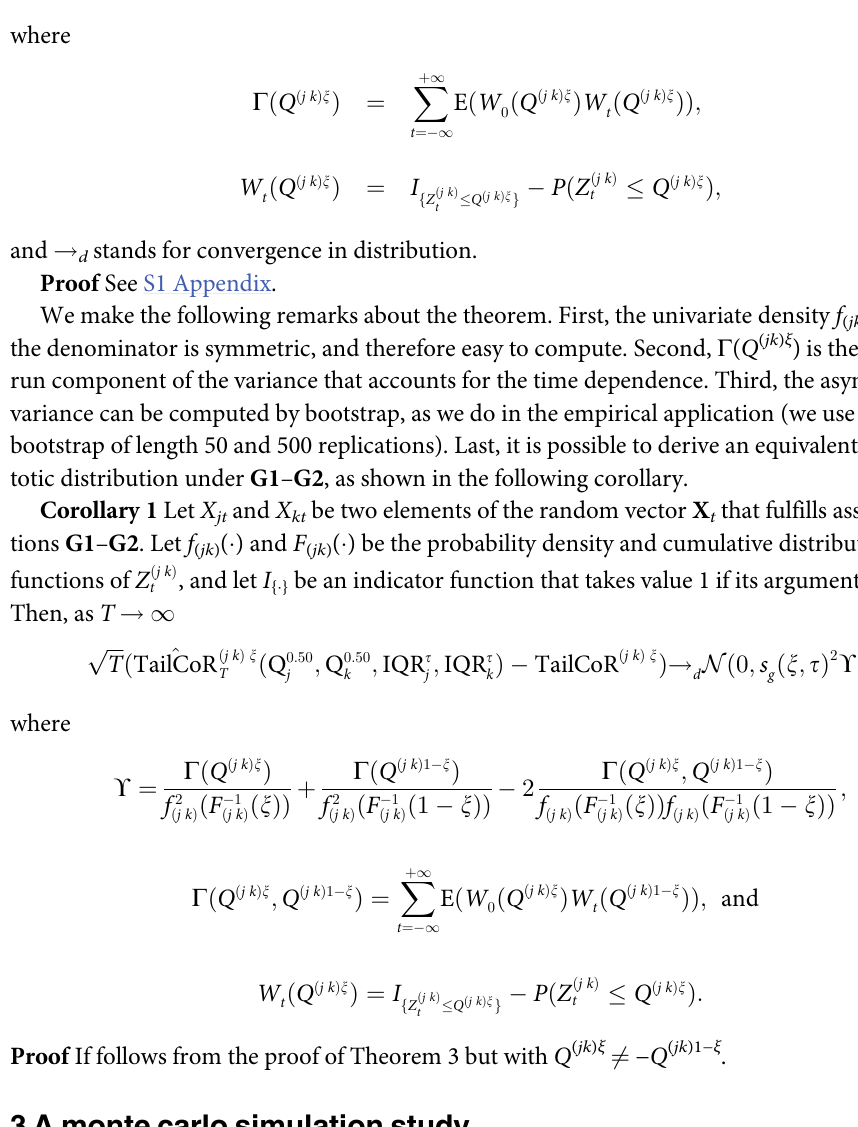
ffiffiffiffiffiffiffiffiffiffiffiffiffiffiffiffiffi p 1 þ 0 : 50 ¼ 1 : 225 . Estimates under